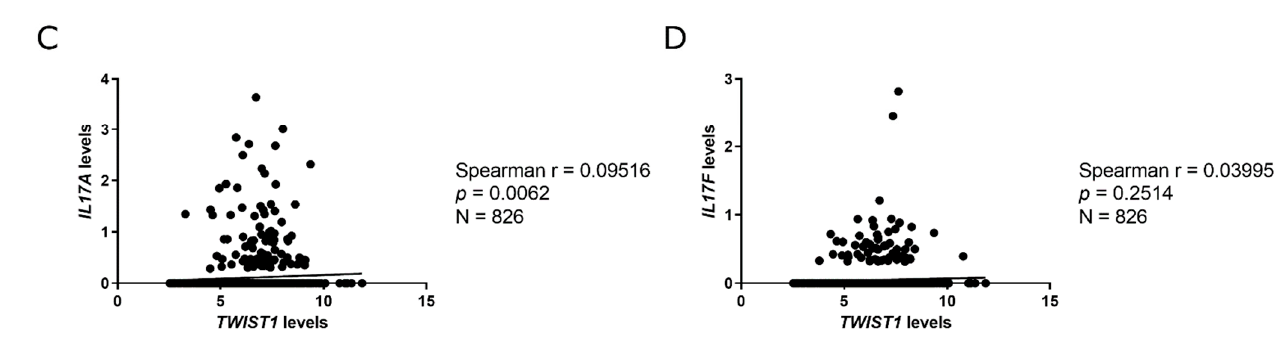
Figure 9. Spearman correlation analysis of the mRNA expression of TWIST1, IL17RC, IL17RA, IL17A, and IL17F in BC samples. Expression values were obtained from TCGA through Linkedomics tools. ( A ) TWIST1 × IL17RC, ( B ) TWIST1 × IL17RA, ( C ) TWIST1 × IL17A, ( D ) TWIST1 × IL17F.